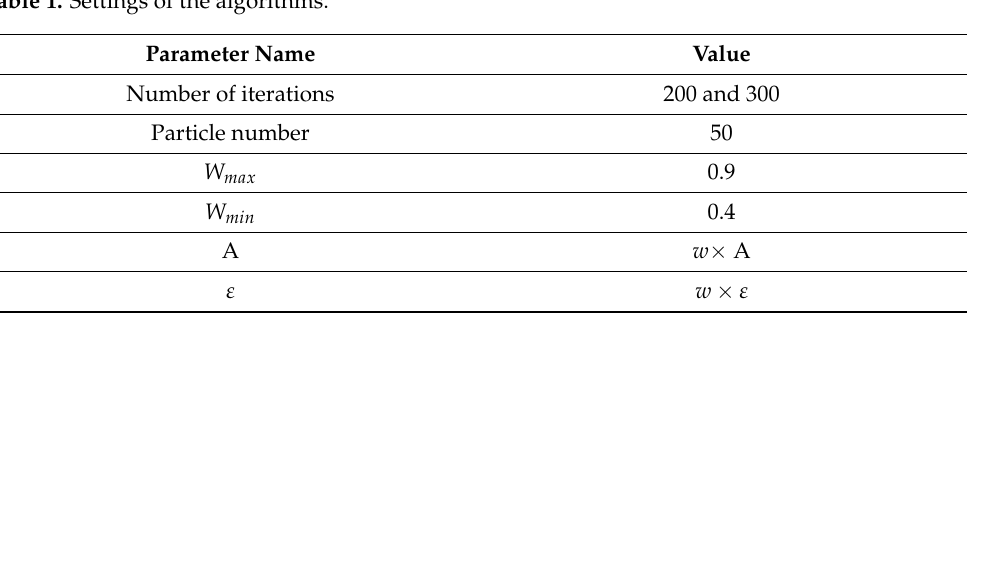
Table 1. Settings of the